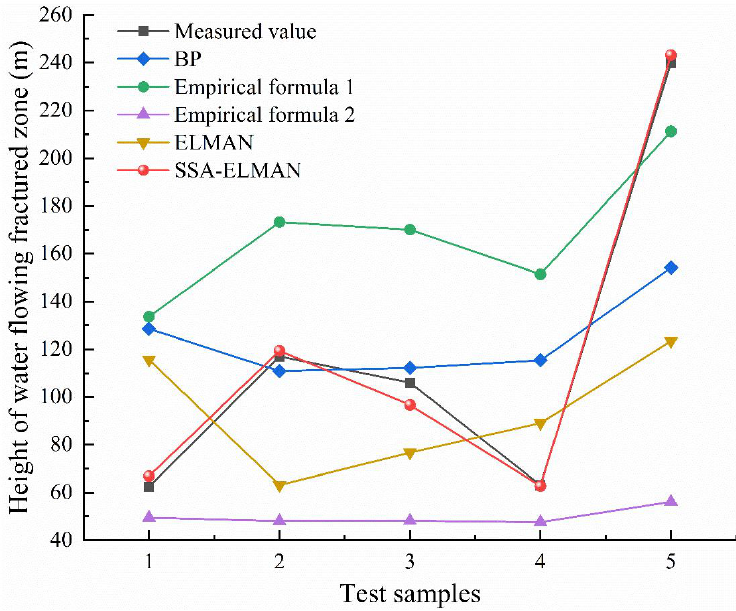
Figure 7. Comparison of prediction performances of different models in the evaluation stage. The contrast of the prediction performances of the various models is shown in Table 2. The MAE values and RMSE values for the predicted values of the height of the WFFZ obtained using the SSA-Elman neural network model are 3.93 and 4.93, respectively, which are less than the corresponding results calculated using the other methods. The results show that using the SSA to optimize the Elman neural network model achieves a higher accuracy than the other prediction methods. Table 2. Contrast of prediction performances of various models in the evaluation